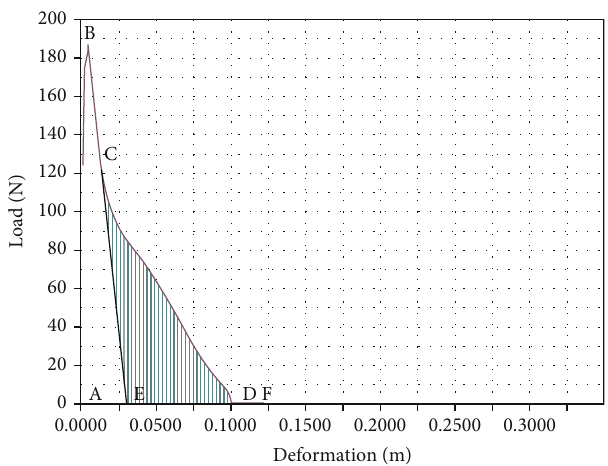
Figure 4: 2# tire rubber powder-modi fi ed asphalt viscosity test load-deformation diagram.